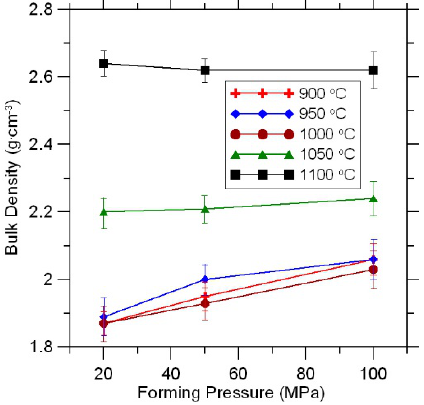
Figure 6. Bulk density versus forming pressure at different firing temperatures.